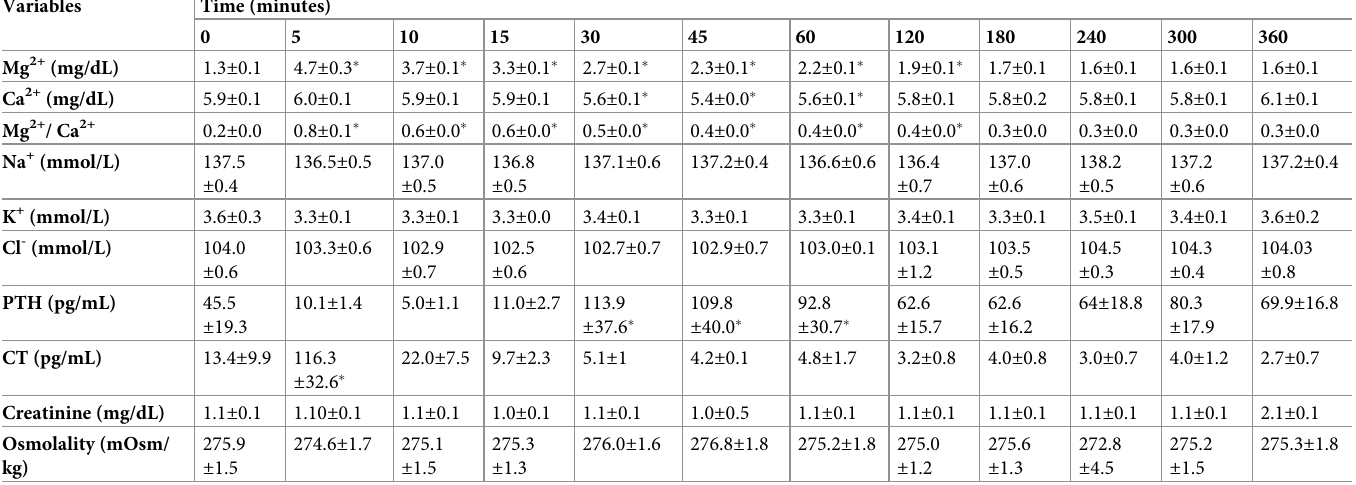
Table 1. Plasma Mg 2+ , Ca 2+ , Na + , K + and Cl - , and serum PTH and CT concentrations, and Mg +2 /Ca 2+ ratio following IV administration of MgSO 4 (60 mg/kg) in healthy horses. Variables Time (minutes)